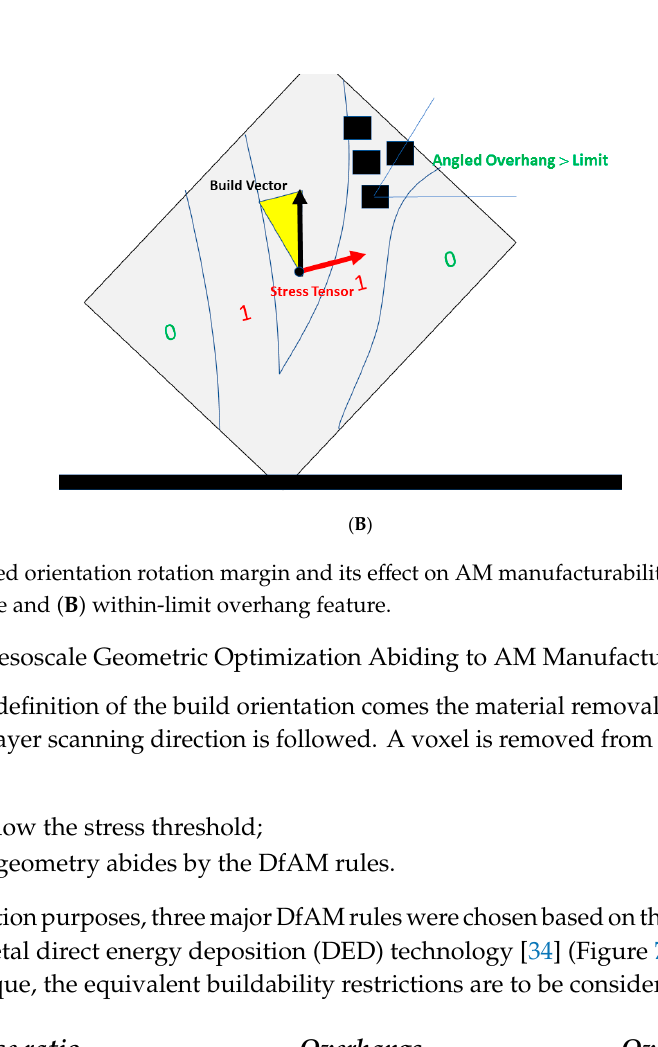
The nature of the function between the contact length of the current layer being built and the previous one dictates the required height–base (HB) ratio for the optimum part’s manufacturing. This is due to the structural and thermal phenomena that are being developed [41]. Oblong geometries (high HB ratio) tend to increase the difficulty of controlling the part’s manufacturing as they have low heat convection and are prone to cracking and detachment from the build bed. The target HB ratio and its margin are further quantified with more thermodynamic insight into the status of the AM process’s nature and the part to be realized [42,43]. Following with the overhanging DfAM rules, the shape optimization algorithm scans the building envelope with the top-down direction, deriving the elements’ load status from the stress analysis and determining the candidate for extraction elements. Next, the algorithm also checks if the remaining geometry creates features that abide by the aforementioned DfAM rules. If the candidate for extraction element does not contradict any rule, its material is removed from the geometry, and the morphing continues. The elements’ possible status is presented in Table 4. Table 4. Definition of voxels’ status. Design Element’s Status 1